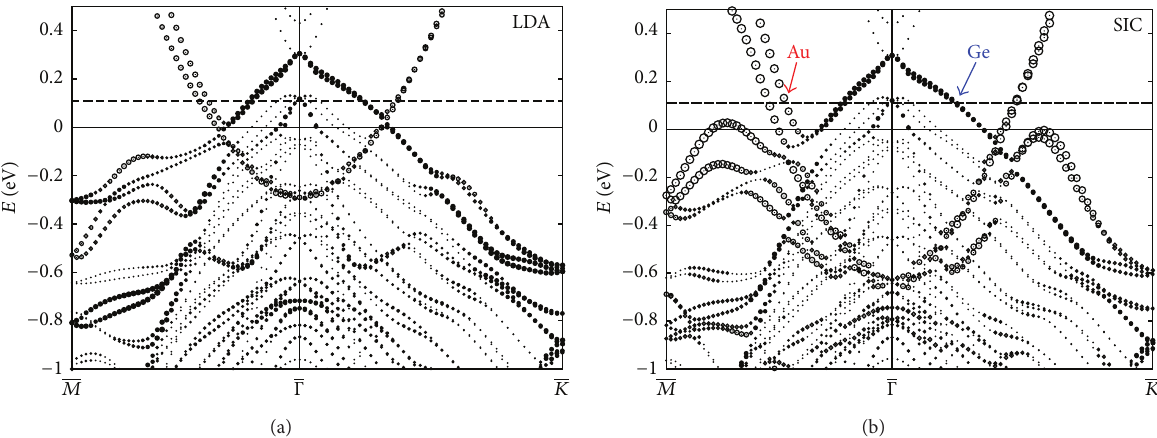
Figure 3: Electronic structure of the CHCT model obtained within the LDA theory (a) and with the SIC-corrected theory (b) along the 𝑀−Γ−𝐾 lines in the surface Brillouin zone. The red and blue arrows in the panel (b) show the states chosen for the presentation in Figure 4.